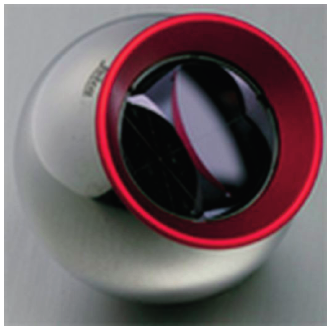
Figure 2. Leica Red-Ring Reflector 1.5 ″ (RRR) with removable ring.